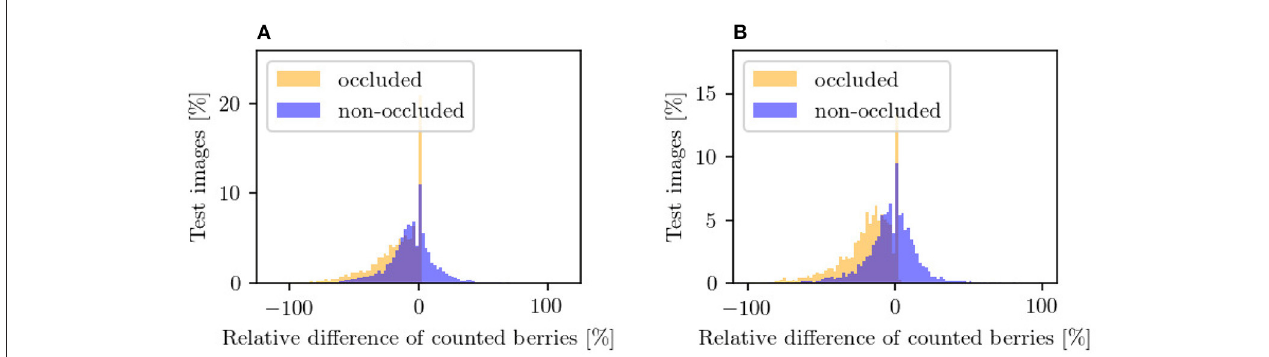
FIGURE 13 | Counting in the occluded domain (orange) and after applying our approach in the non-occluded domain (blue) relative to the reference counting in the non-occluded domain. The plots illustrate the results for (A) VSP defoliation and (B) SMPH defoliation. A negative value means that fewer berries are counted than in the reference and vice versa . Each bar corresponds to a width of